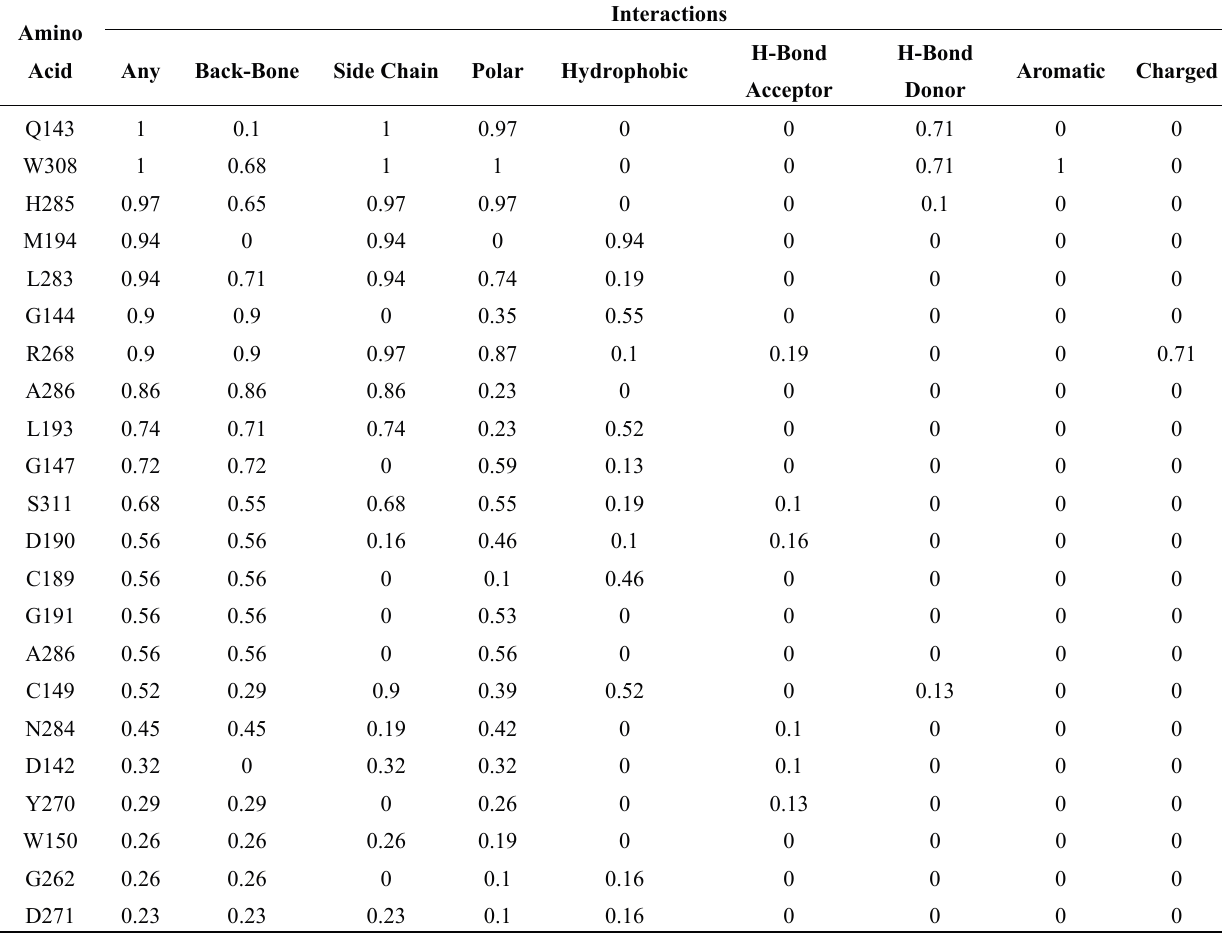
Table 4. An averaged structural interaction fingerprint ( SIF t) calculated over all successfully docked poses among two receptor conformations and 40 ligands presented for all identified interacting